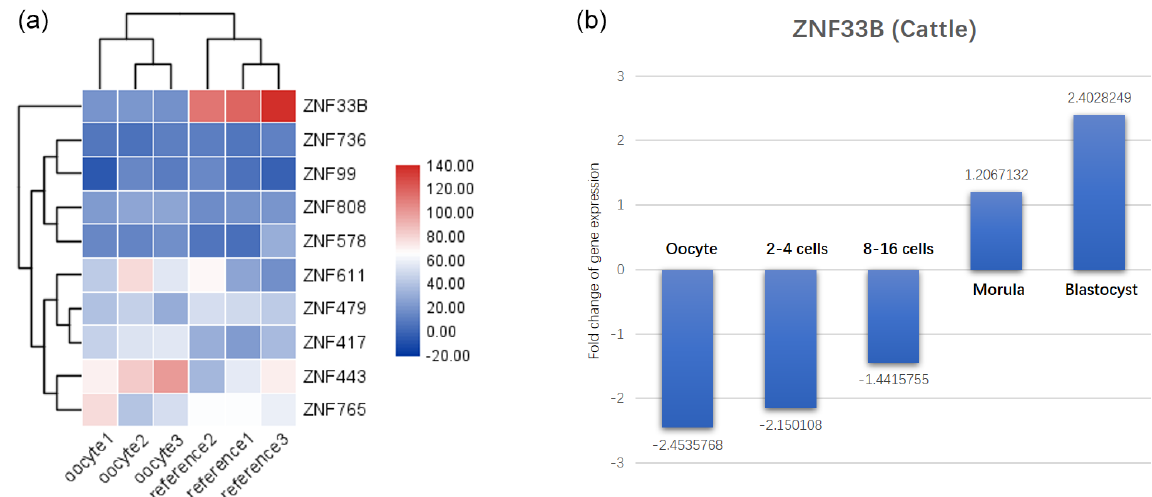
Figure 1. Identification results of recently duplicated genes in KRAB-ZNFs during oocyte development. (a) Analysis of 10 rapidly differenti- ating genes in human oocytes and significantly decreased expression of ZNF33B. (b) ZNF33B was found to be consistently poorly expressed at the oocyte and 2–16 cell stages in transcriptomic data from developing bovine embryos, but the expression was gradually upregulated. Upon entering the mulberry embryo and blastoderm stage, ZNF33B was in a high expression state. Table 1. Sequence of the primer. Sequence Size (bp) Annealing temperature F GGAAGTTAAACAGCCTAGT 620 54 ◦ R